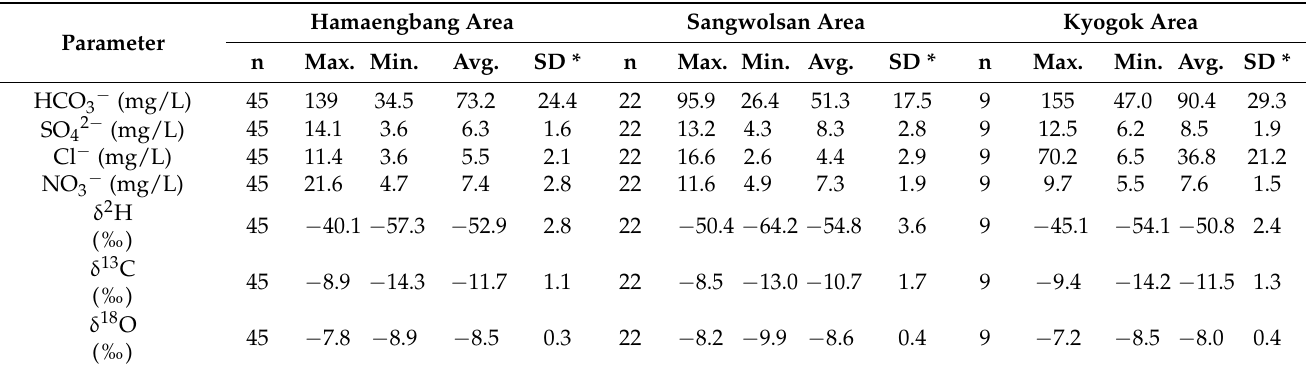
Figure 3 shows a piper diagram of the cations and anions in the surface water samples. The dominant cation and anion in the surface water samples were Ca 2+ and HCO 3 − , respec- tively, and most of the water quality ions were the Ca-Mg-HCO 3 -type. This classification is characteristic of surface water that has been directly influenced by the atmosphere, and it is likely that carbonate rock dissolution (weathering) significantly affects the hydrology of this region [42,43]. However, SO 42 − and Cl − ions also increased in some surface waters near the East Sea due to the effect of farmland and brackish water.